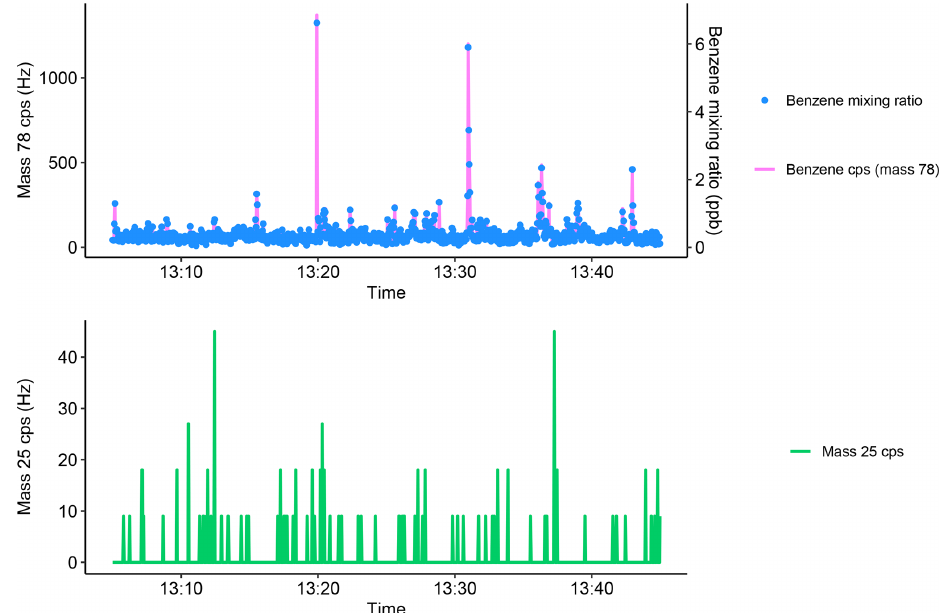
Figure A1. Example of instrument noise during mobile measurements. The blue points show the mixing ratio of benzene, and the pink line shows the corresponding counts per second for the benzene ion counts per second (mass 78). The green line shows the variation of mass 25 during mobile measurements, which does not contain any periods of elevated noise.